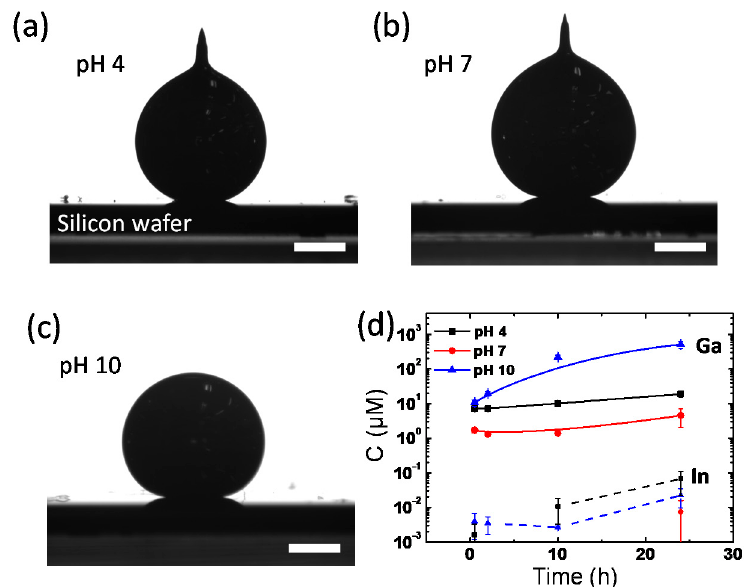
Figure 6. Side-view images of EGaIn droplets placed on a Si wafer in ( a ) pH 4, ( b ) pH 7. and ( c ) pH 10 buffer solutions at 20 °C. Scale bars are 0.5 mm. ( d ) Time-dependent Ga and In ion concentrations dissolved into buffer solutions from the EGaIn liquid metal droplet.